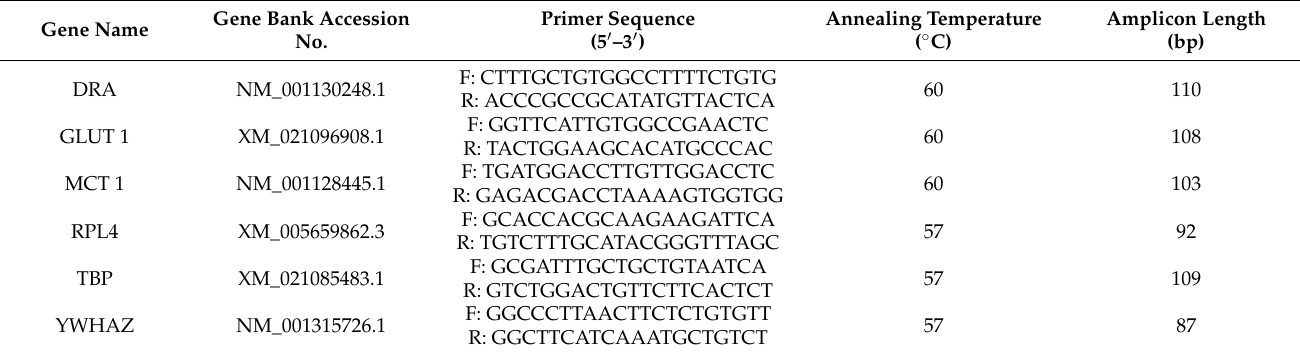
Table 1. Primers used for